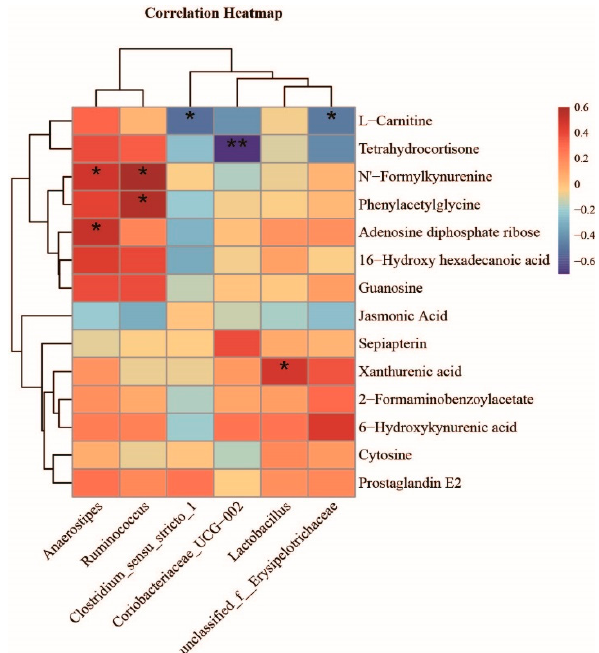
Figure 8. Correlation plot showing the relationship between metabolites from the feces and gut bacteria. Correlation analysis was performed using Spearman’s method (* p < 0.05, ** p < 0.01).